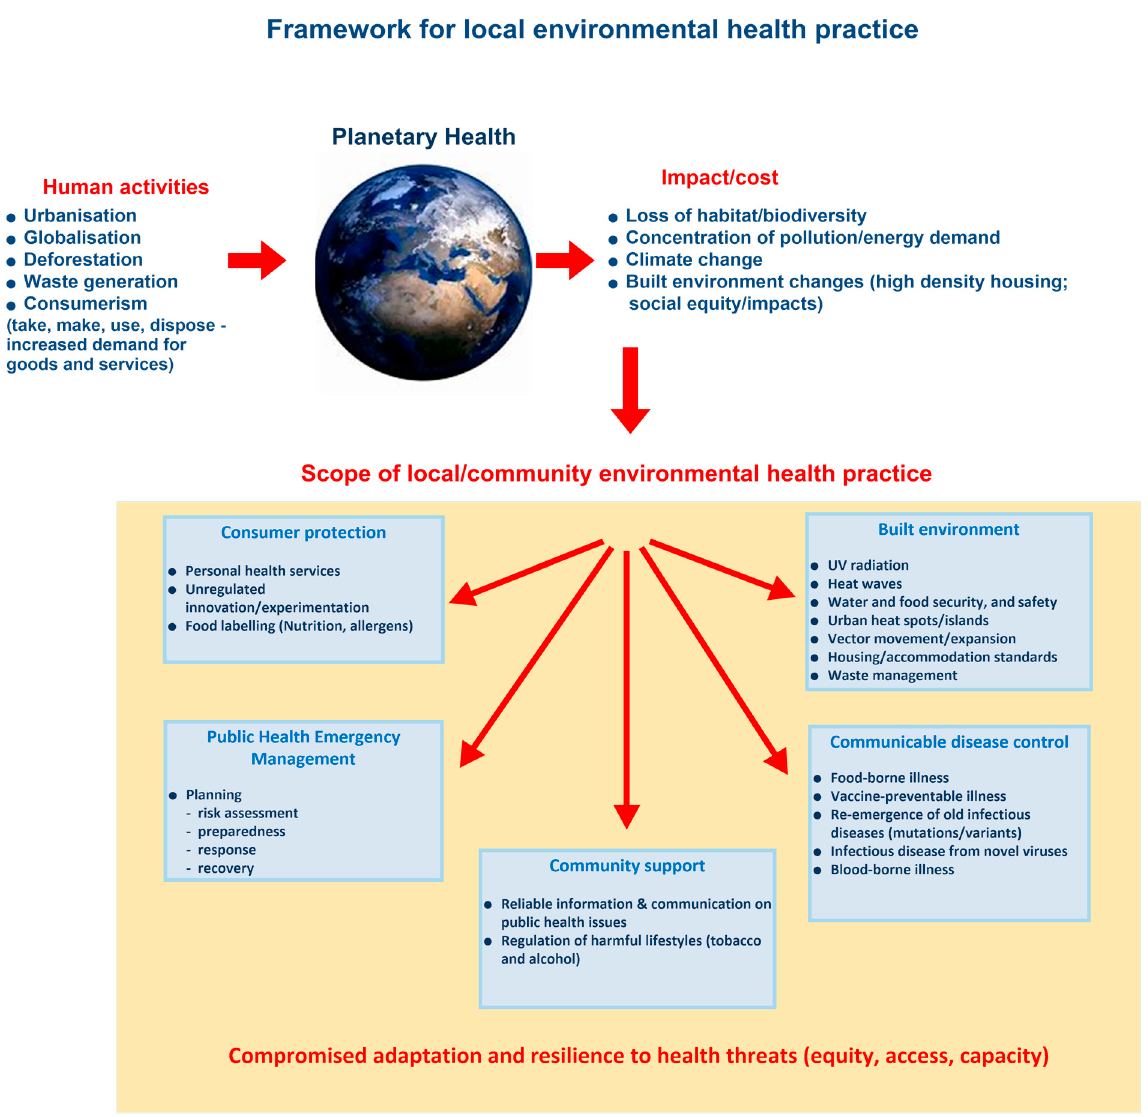
Figure 3. Framework of local environmental health practice. to assist the reconceptualization of the scope of practice required for the planning and response to climate change.